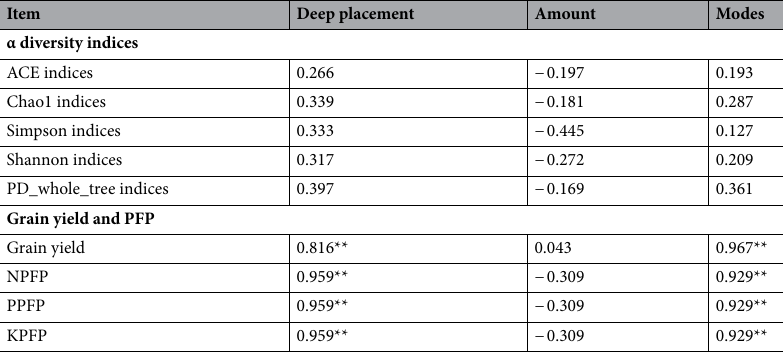
Table 5. Pearson correlation analysis of α diversity index, grain yield, PFP, and different fertilization modes and their composition. “*” means significant correlation (p < 0.05), “**” means extremely significant correlation (p < 0.01); Deep placement indicates the deep application of slow-release fertilizer; Amount indicates the amount of slow-release fertilizer applied; Modes indicates the different fertilization modes of slow-release